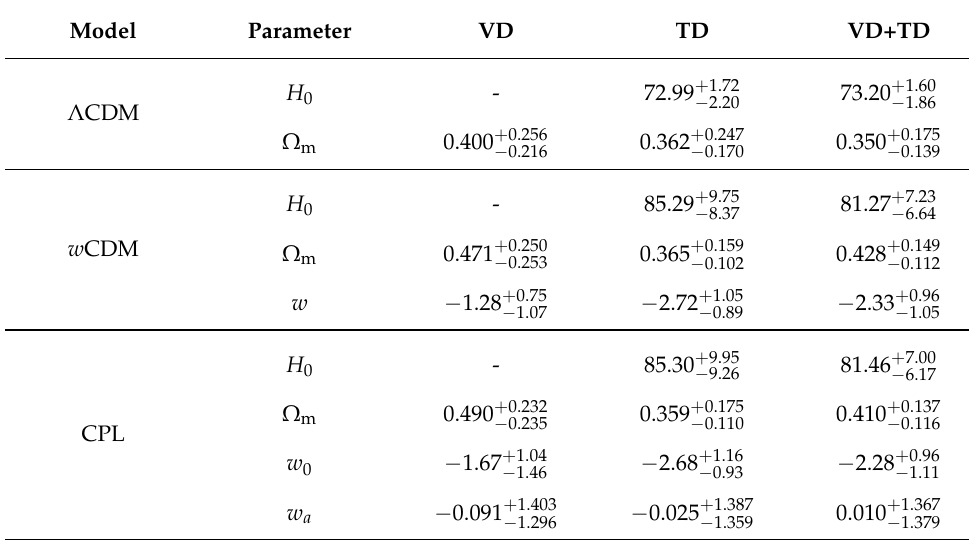
Figure 3. The constraints (68.3% and 95.4% confidence level) on the CPL model from VD, TD, and VD+TD. Table 2. The constraints on cosmological parameters of the Λ CDM, w CDM and CPL models from the current VD, TD, and VD+TD. Here H 0 is in units of km s − 1 Mpc − 1